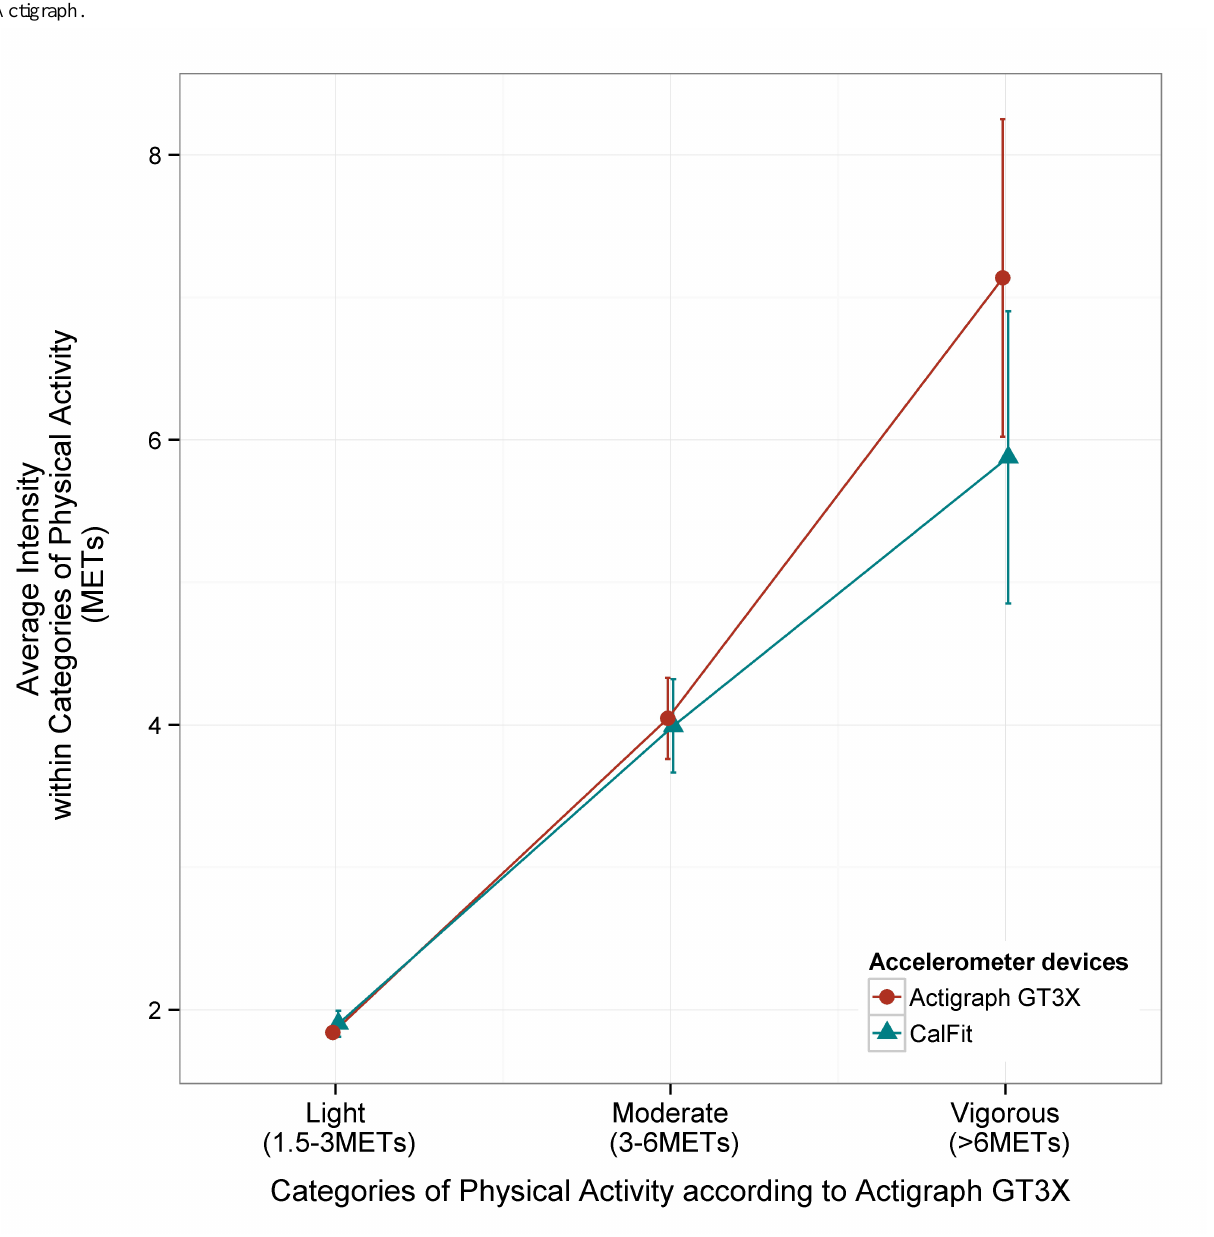
Figure 4. Comparison of average intensity recorded by CalFit and Actigraph GT3X within light, moderate, and vigorous physical activity identified by Actigraph.